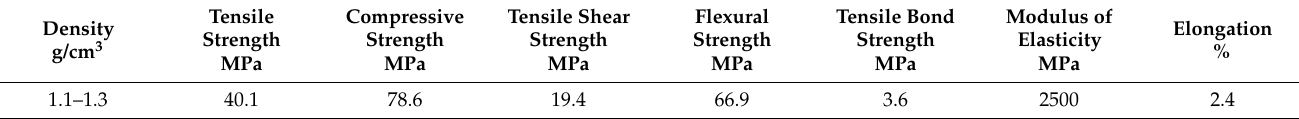
Table 1. Performance index of carbon fiber impregnated in